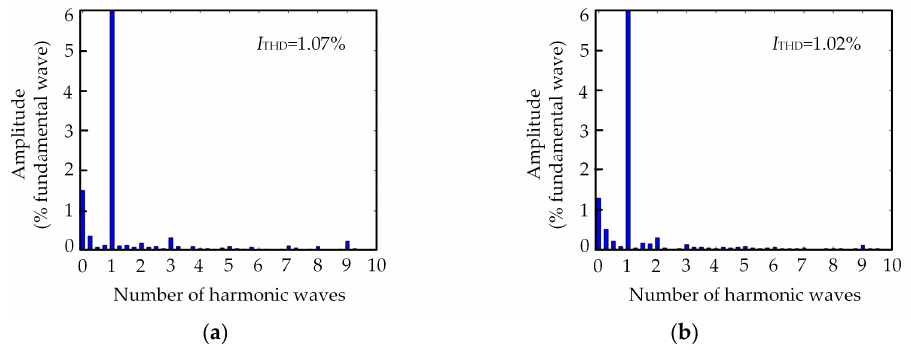
Figure 24. The total harmonic distortion of the output current at cos φ = 0.954 ( N = 4). ( a ) The proposed modulation approach, ( b ) the conventional modulation approach.